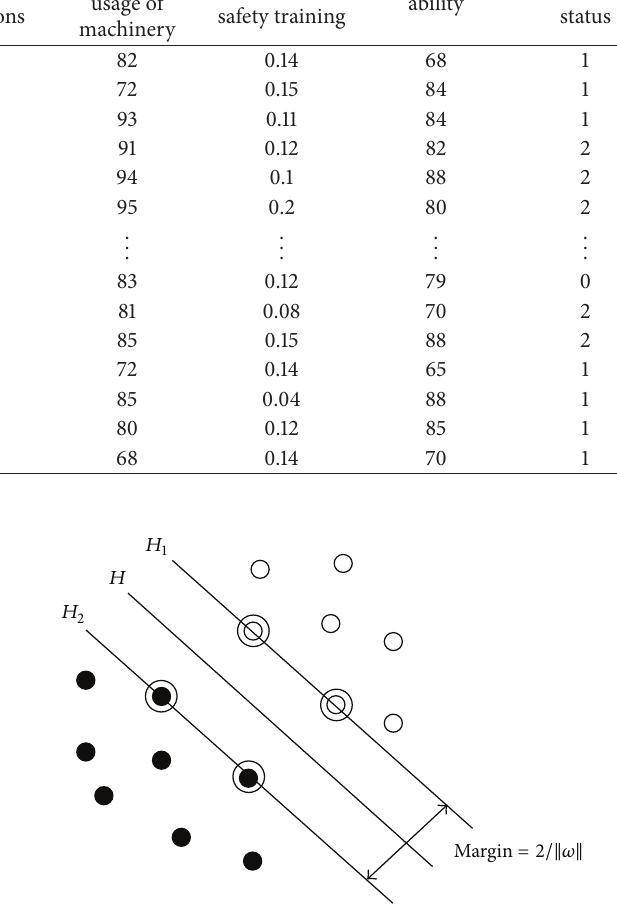
Figure 5: Linearly separable cases with optimal classification